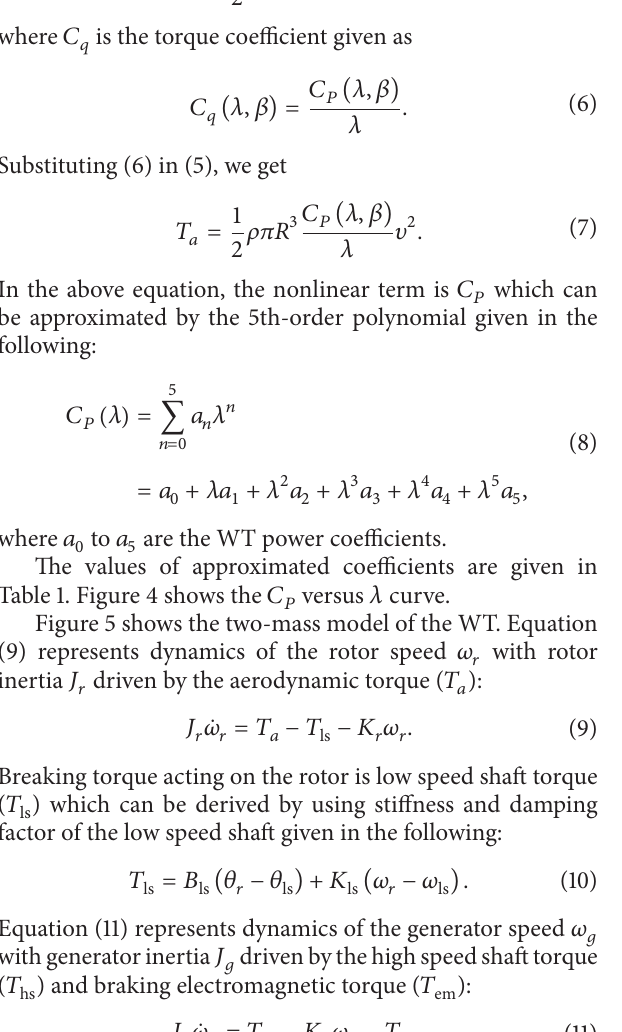
Figure 4: 𝐶 𝑃 versus 𝜆